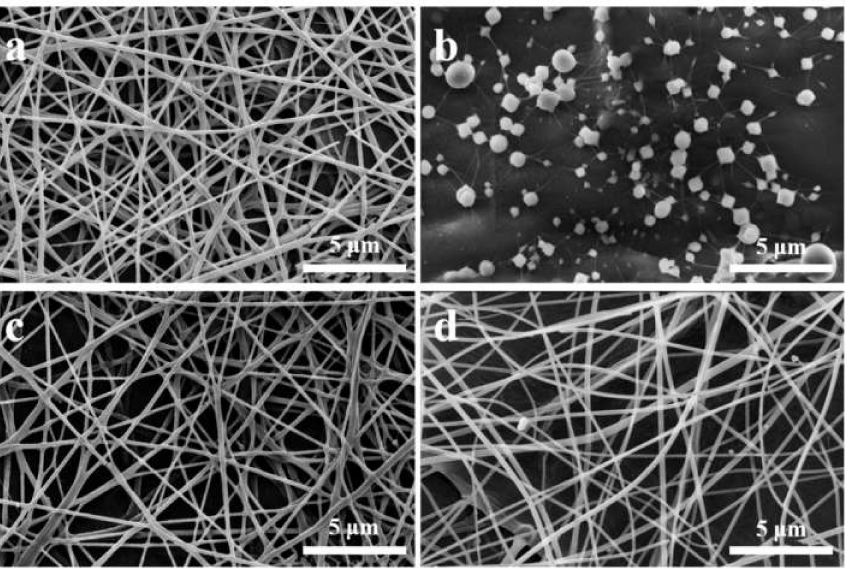
Figure 1. SEM images of SA nanofibres spun with the four di ff erent sample solutions: ( a ) I; ( b ) II; ( c ) III and ( d )